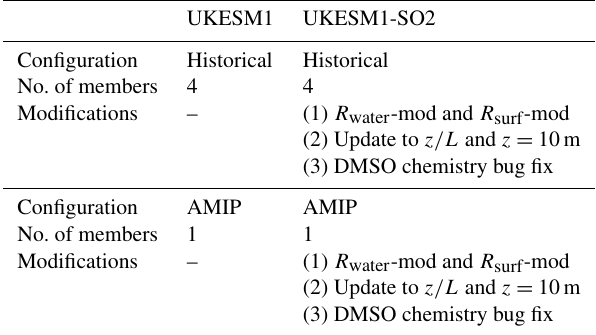
Table 2. Summary of model configurations used in this